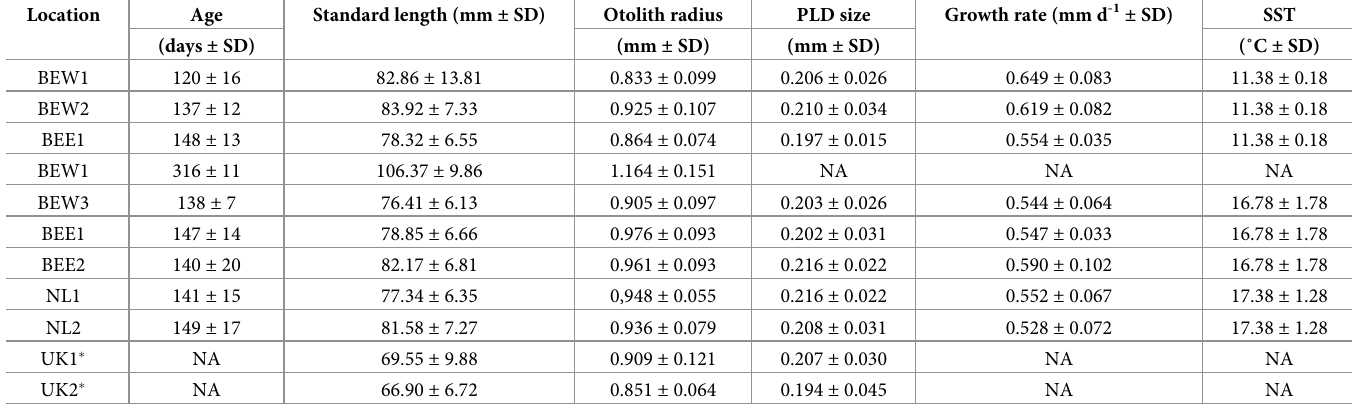
Absolute growth rate and pelagic larval growth Linear proportionality between standard fish length (SL, mm) and otolith radius (OR, mm) was recorded ( R 2 = 0.45, p < 0.001), confirming their independent but concurrent growth in time, at least for juvenile 0-group sole: SL ¼ 24 : 1 þ 57 : 74 OR þ ε ð 1 Þ However, only a weak quadratic age-length key could be detected from the growth curve between otolith radius (OR, mm) and age (A, days) using a generalized additive model that Table 3. Growth parameters (age, standard length, otolith radius, PLD size and growth rate) averaged per location. Growth rate was calculated from the individual ratios between standard fish length and age at capture. Also calculated SST at the estimated arrival time at the different nursery grounds is given.